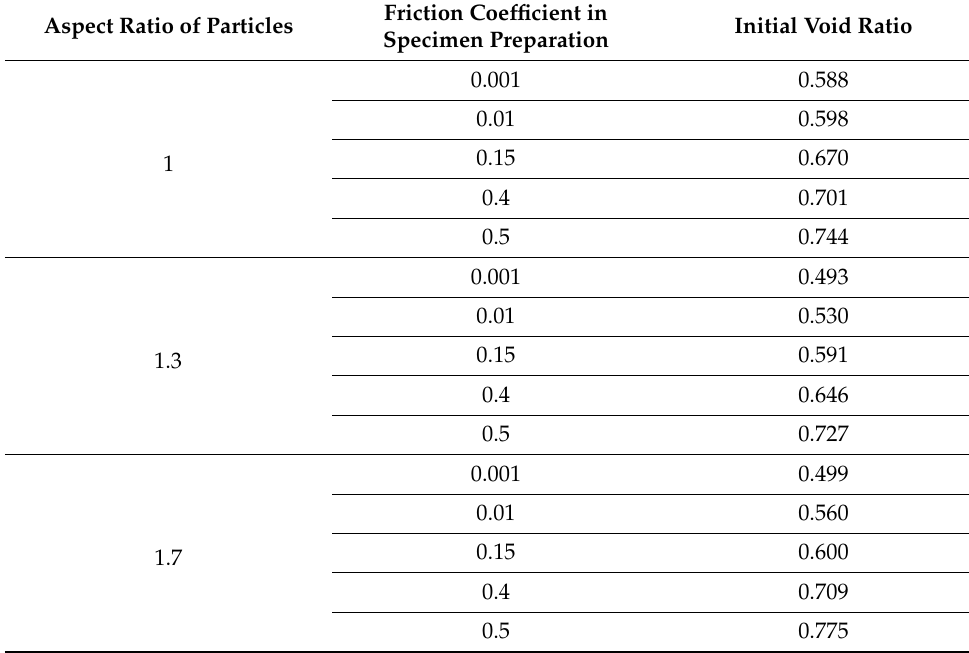
Table 2. Summary of the test